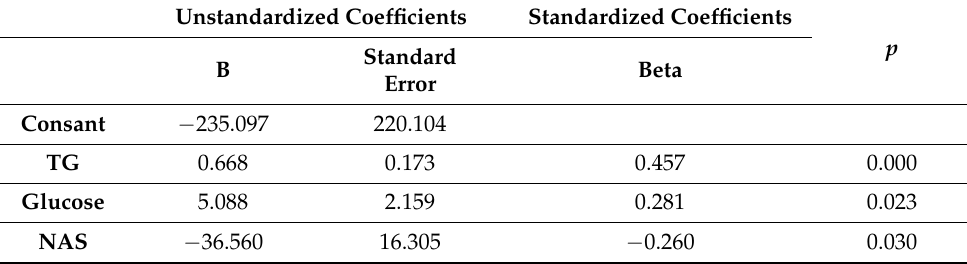
lipoprotein cholesterol, GGT: gama glutamyl transpeptidase, HOMA-IR: homeostasis model assessment of insulin re- sistance. In Model 1 only the triglyceride, in Model 2 the trigliyceride and glucose and in Model 3 the triglyveride, glocose and NAS were the constant variables. ** Beta represents the “standardized coefficients”. Table 3. Independent predictors of betatrophin according to the Stepwise Multiple Regression Test.